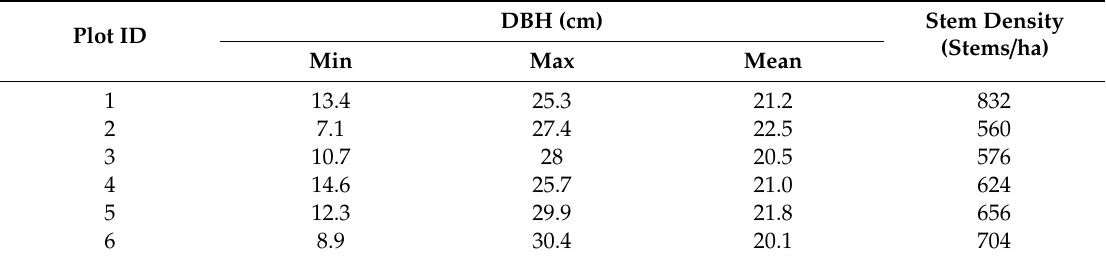
Table 3. Summary of trees in each test plot with a diameter of breast height (DBH) and density. Plot ID